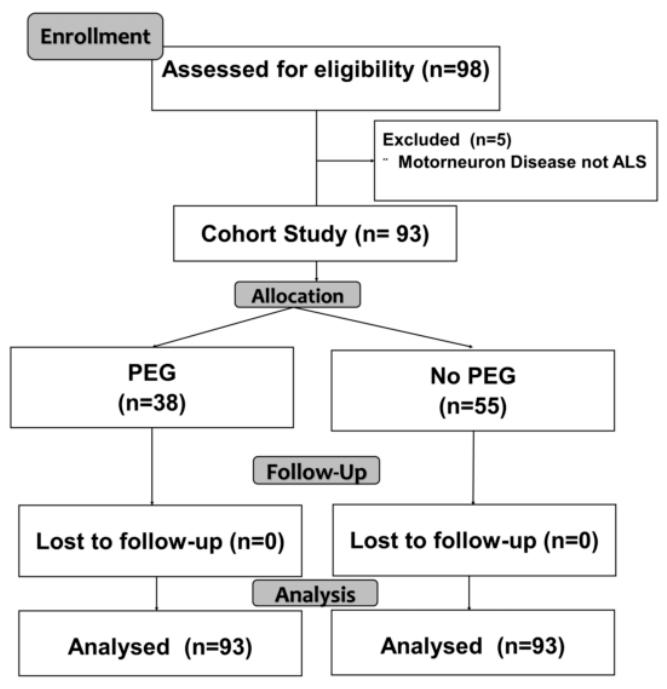
Figure 1. Flow Chart.